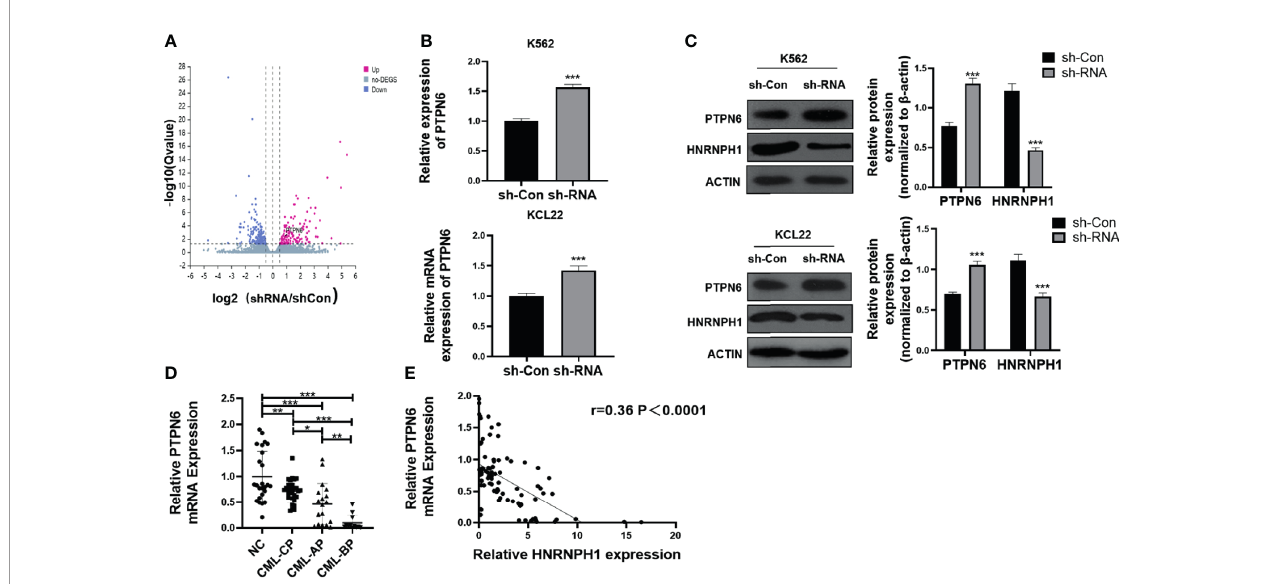
FIGURE 4 | HNRNPH1 regulatesthePTPN6 expression. (A) Threeindependent HNRNPH1 reduced andcontrolcells werepreparedfor RNA preparationandmicroarray analysis. Geneswithaltered expressionwere displayed involcanoplots. Theupregulatedgenes are highlightedin pinkanddownregulatedgenes inblue. (B) K562andKCL22 cellsweretransfectedwithspeci fi c sh-RNA ofHNRNPH1 or negativesh-RNA (sh-Con). qRT-PCR was usedto detectthe PTPN6mRNA level. ***P< 0.001 vs. sh-Con. (C) CML cellswerepreparedas (B) , westernblot wasused to detect PTPN6 proteinlevel. Right panel, densitometric analysis. ***P < 0.001 vs. sh-Con. (D) qRT-PCRwas used to detectPTPN6 mRNAlevelindifferentphasesof CML(CML-CP, CML-AP, andCML-BP) patients ’ BM-MNCscomparedwithnormal controls. *P <0.05,**P <0.01, ***P < 0.001. (E) Pearsoncorrelation analysis was usedto analyze therelationshipbetween HNRNPH1andPTPN6inBM-MNCsof CMLpatients (R = 0.36, P <0.0001).